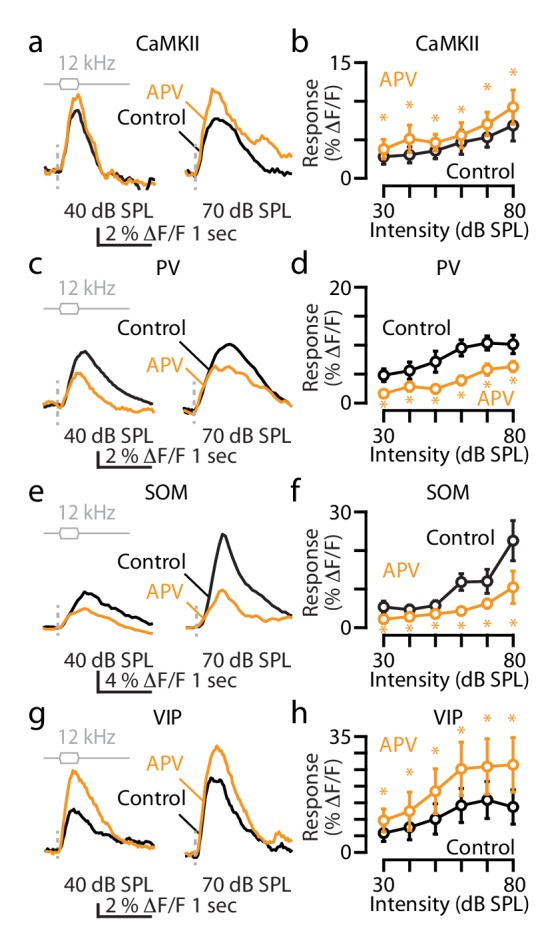
The effect of APV on the sound-evoked responses of principal, PV, SOM and VIP neurons.(a) Transcranial fluorescence responses of principal neurons to 12 kHz sounds of 40 and 70 dB SPL before and after APV infusion. (b) Average responses of principal neurons to 12 kHz sounds of different intensities in control (black) and after APV (gold; control vs. APV for 30 dB: p=0.005, 40 dB: p=0.016, 50 dB: p=0.039, 60 dB: p=0.006, 70 dB: p=0.042; 80 dB: p=0.014, n = 6 mice, paired t-tests). (c) Same as in (a) but for PV neurons. (d) Same as in (b) but for PV neurons (control vs. APV for 30 dB: p=0.001, 40 dB: p=0.017, 50 dB: p=0.003, 60 dB: p=0.005, 70 dB: p=0.001; 80 dB: p<0.001, n = 6 mice, paired t-tests). (e) Same as in (a) but for SOM neurons. (f) Same as in (b) but for SOM neurons (control vs. APV for 30 dB: p=0.018, 40 dB: p=0.036, 50 dB: p=0.039, 60 dB: p=0.001, 70 dB: p=0.024; 80 dB: p=0.011, n = 4 mice, paired t-tests). (g) Same as in (a) but for VIP neurons. (h) Same as in (b) but for VIP neurons (control vs. APV for 30 dB: p=0.005, 40 dB: p=0.016, 50 dB: p=0.039, 60 dB: p=0.006, 70 dB: p=0.033; 80 dB: p=0.042 n=4 mice, paired t-tests). Detailed values: (b) 30 dB SPL: control: 2.6 ± 0.5% ΔF/F, vs APV, p=0.005; 40 dB SPL: control: 2.8 ± 0.6% ΔF/F, vs. APV, p=0.01; 50 dB SPL: control: 3.3 ± 0.9% ΔF/F, vs. APV, p=0.04; 60 dB SPL: control: 4.3 ± 1.4% ΔF/F, vs. APV, p=0.006, 70 dB SPL: control: 4.9 ± 1.2% ΔF/F, vs. APV, p=0.04; 80 dB SPL: control: 6.3 ± 1.9% ΔF/F, vs APV, p=0.01, paired t-tests, n = 6 mice. (c) 30 dB SPL: control: 4.4 ± 0.7% ΔF/F, vs. APV, p=0.001; 40 dB SPL: control: 5.1 ± 1.1% ΔF/F, vs. APV, p=0.001; 50 dB SPL: control: 6.6 ± 1.3% ΔF/F, vs. APV, p=0.003; 60 dB SPL: control: 8.8 ± 1.3% ΔF/F, vs. APV, p=0.005, 70 dB SPL: control: 9.5 ± 1.5% ΔF/F, vs. APV, p=0.001; 80 dB SPL: control: 9.3 ± 1.5% ΔF/F, vs. APV, p=0.001, paired t-tests, n = 6 mice. (e) 30 dB SPL: control: 5.3 ± 1.5% ΔF/F, vs. APV, p=0.02; 40 dB SPL: control: 4.7 ± 1.2% ΔF/F, vs. APV, p=0.04; 50 dB SPL: control: 5.8 ± 1.2% ΔF/F, vs APV, p=0.04; 60 dB SPL: control: 11.8 ± 3.1% ΔF/F, vs. APV, p=0.001, 70 dB SPL: control: 12.0 ± 3.1% ΔF/F, vs. APV, p=0.02; 80 dB SPL: control: 22.5 ± 5.2% ΔF/F, vs. APV, p=0.01, paired t-tests, n = 4 mice. (f) 30 dB SPL: control: 5.4 ± 2.3% ΔF/F, vs. APV, p=0.03; 40 dB SPL: control: 7.0 ± 3.4% ΔF/F, vs. APV, p=0.009; 50 dB SPL: control: 9.3 ± 4.2% ΔF/F, vs. APV, p=0.03; 60 dB SPL: control: 13.0 ± 4.7% ΔF/F, vs. APV, p=0.03, 70 dB SPL: control: 14.6 ± 5.2% ΔF/F, vs. APV, p=0.03; 80 dB SPL: control: 12.6 ± 4.8% ΔF/F, vs. APV, p=0.04, paired t-tests, n = 4 mice.